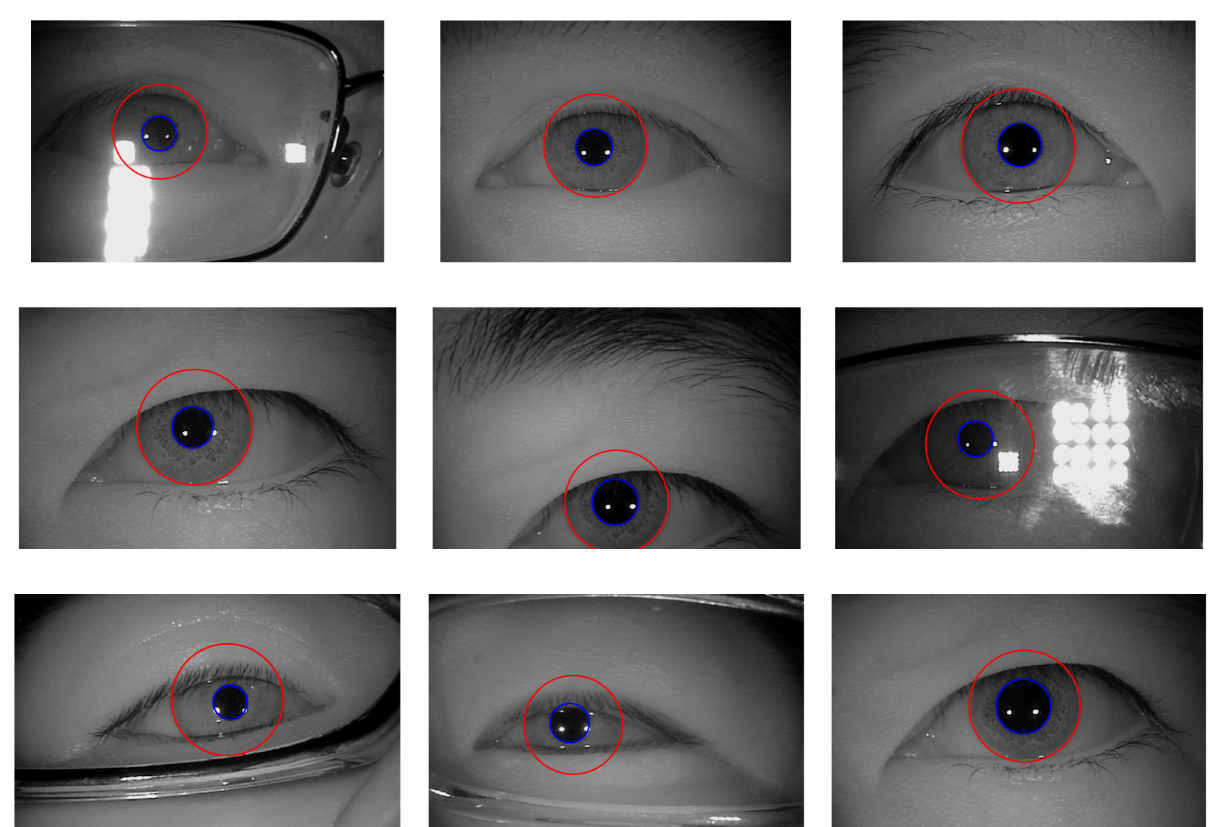
Figure 11. Example results of outer and inner boundary